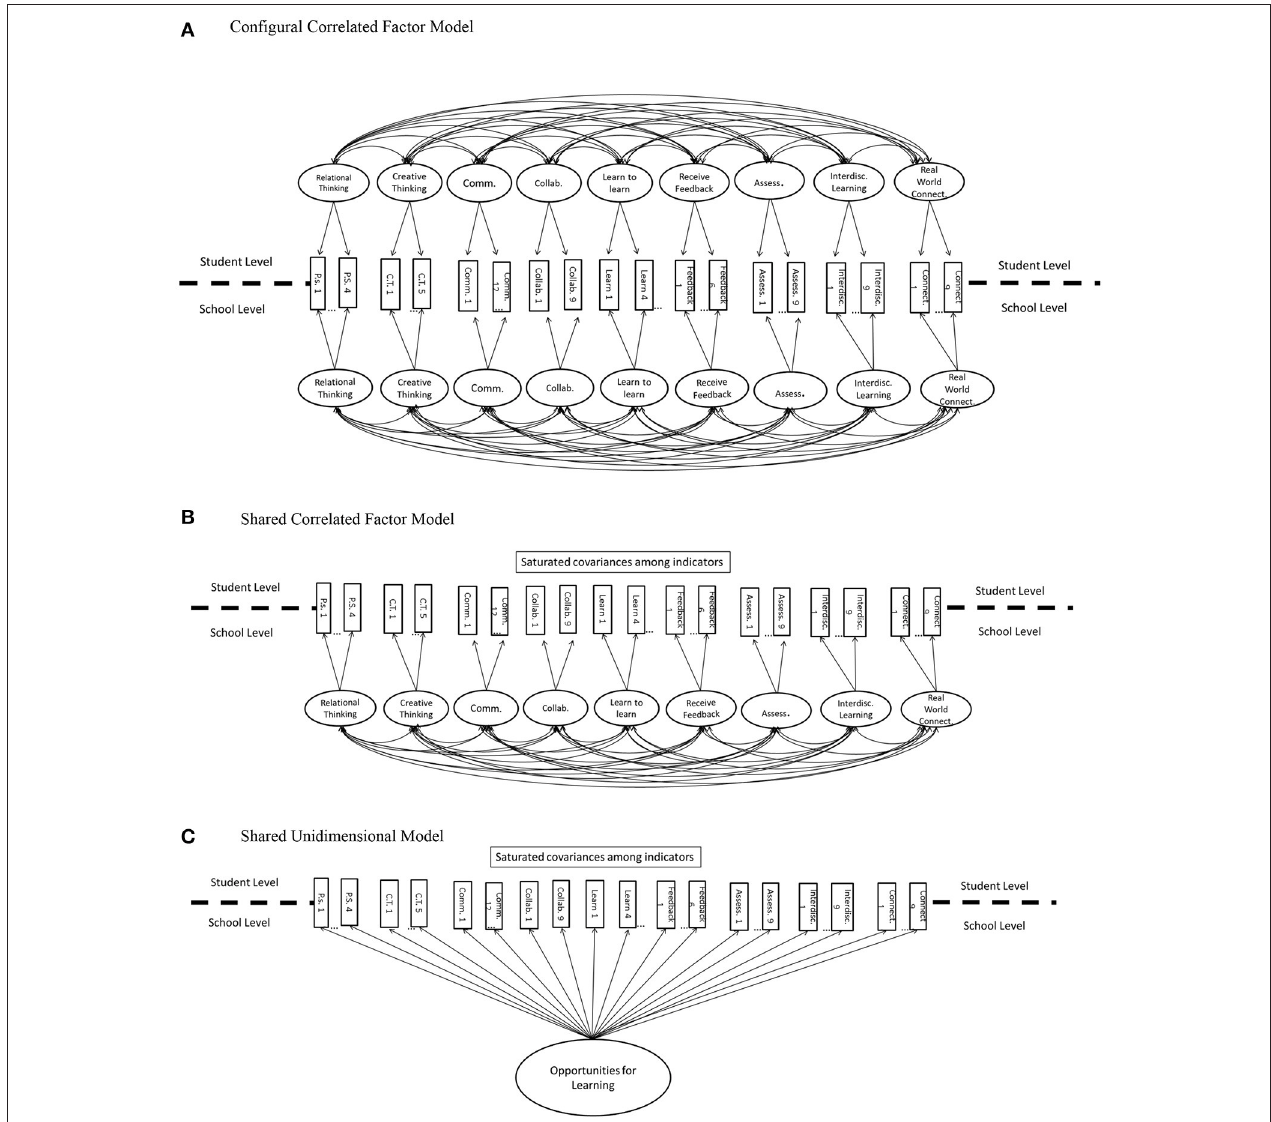
FIGURE 3 | Theoretically plausible systematically compared at both student and school levels: (A) Configural Correlated; (B) Shared Correlated; and (C) Shared Unidimensional Factor Model. Error terms are not depicted here for